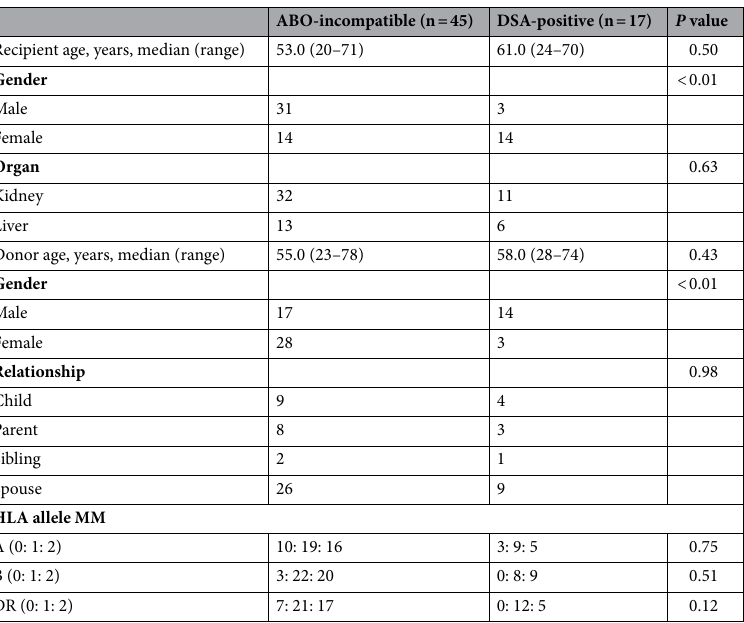
Table 1. Characteristics of ABO-incompatible and DSA-positive patients. A difference was considered significant if the p-value was